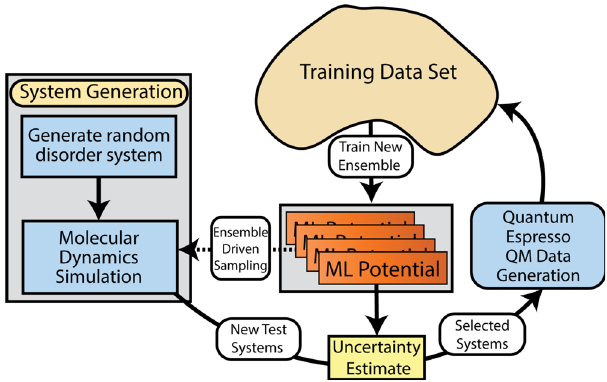
Fig. 9 Diagram of active learning for data collection. Multiple active learning cycles can be run simultaneously, with occasional synchronization points to merge new data into a single global dataset. The sampling, data generation, and training steps all bene fi t from graphics processing unit (GPU)